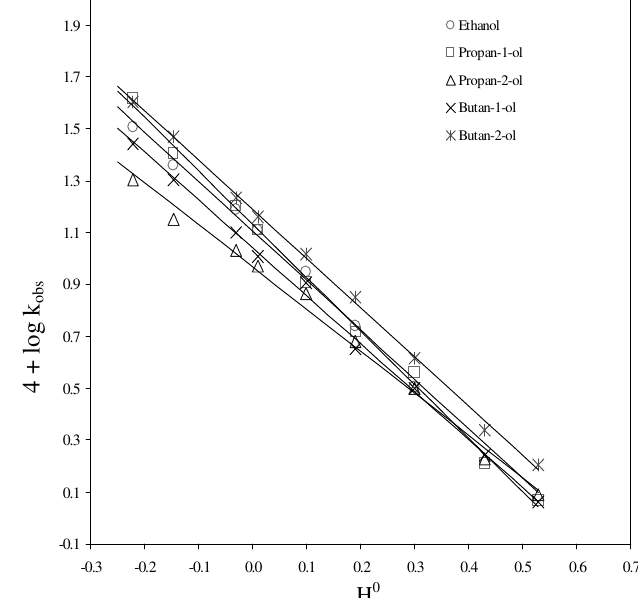
Figure 5. Zucker hammett plots in perchloric acid media.